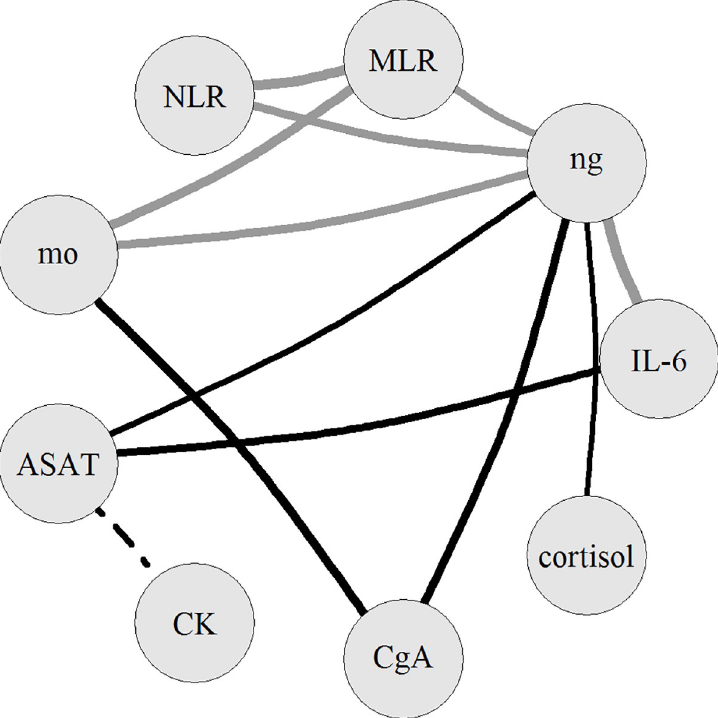
Fig 3. Major associations of inflammatory factors, cell damage markers and stress markers on the next day after stenting. ng: neutrophil count, mo: monocyte count, NLR: neutrophil-to-lymphocyte ratio, MLR: monocyte-to- lymphocyte ratio. Only correlations with r > 0.7, p < 0.0001 are shown, the thickness of a line is proportional to the value of Pearson’s correlation coefficient (r). A black line represents an association of an inflammatory factor with a cell damage factor or a stress marker; associations among inflammatory factors are shown in grey, while the correlation of cell damage factors with dashed line.